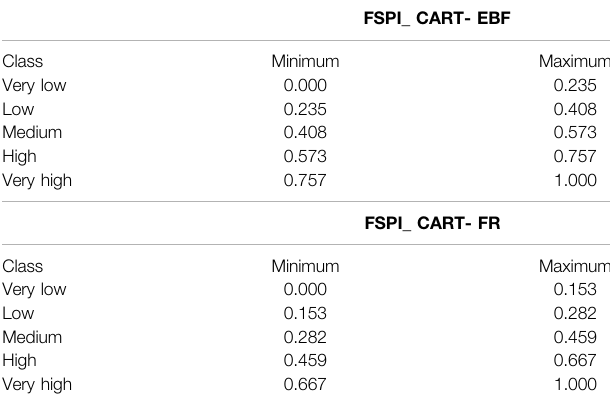
TABLE 6 | Minimum and maximum FSPI values for all the fl ood susceptibility classes as per CART- EBF and CART-RF models.